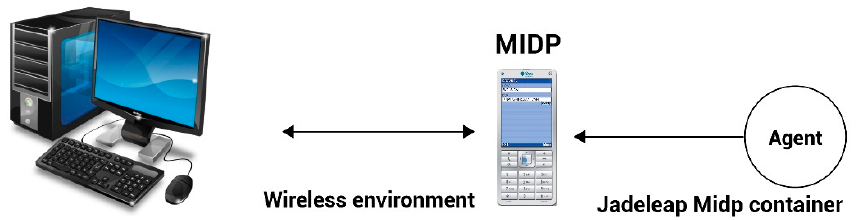
Figure 9. JADE-Lightweight Extensible Agent (LEAP) Platform Using Mobile Information Device Profile (MIDP).